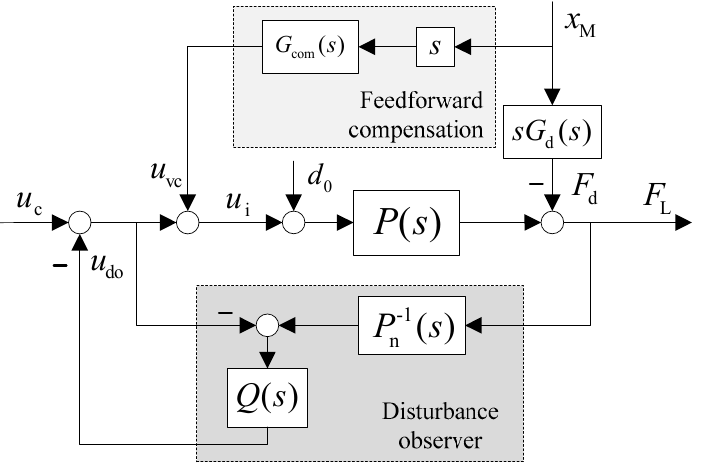
10 of 27 Figure 6. Disturbance force after constant compensation.